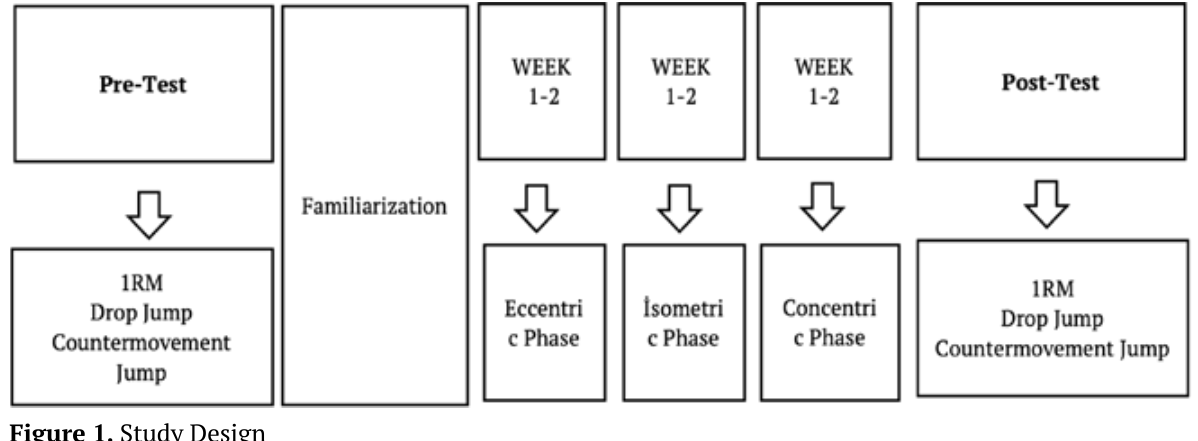
Figure 1. Study Design